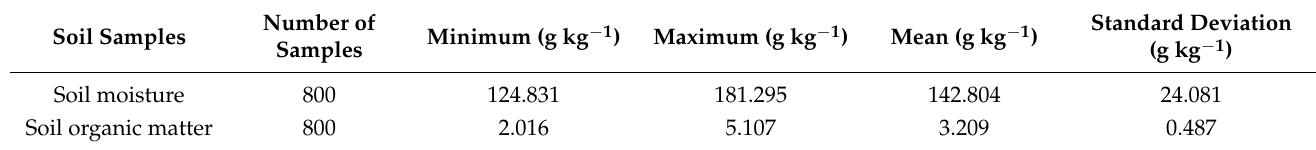
Table 1. Statistics of moisture and organic matter content of soil